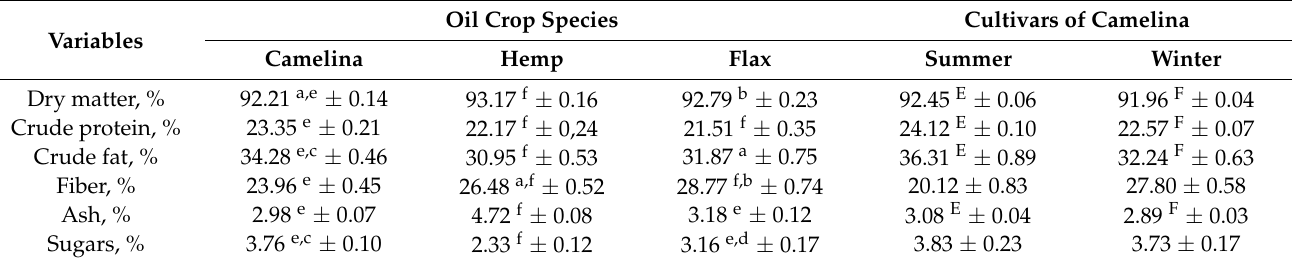
Table 1. Seed proximate